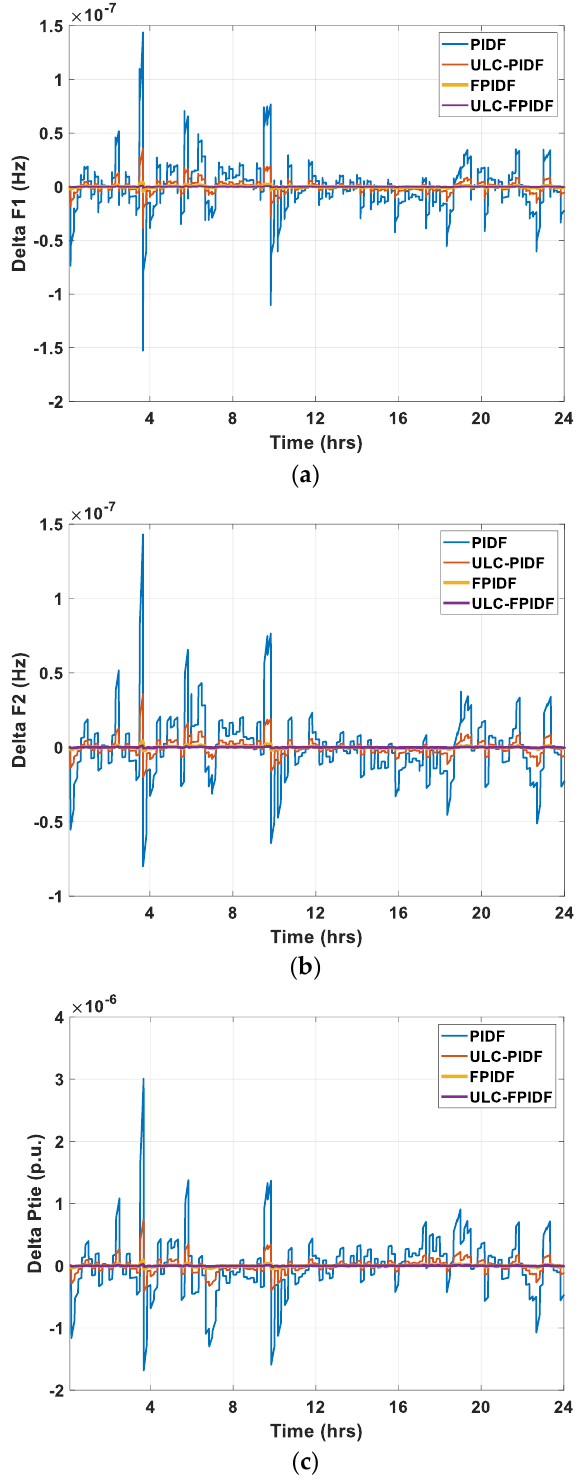
Figure 17. Dynamic response using different controllers through RES fluctuation: ( a ) ΔF 1 , ( b ) ΔF 2, and ( c ) ΔP tie .